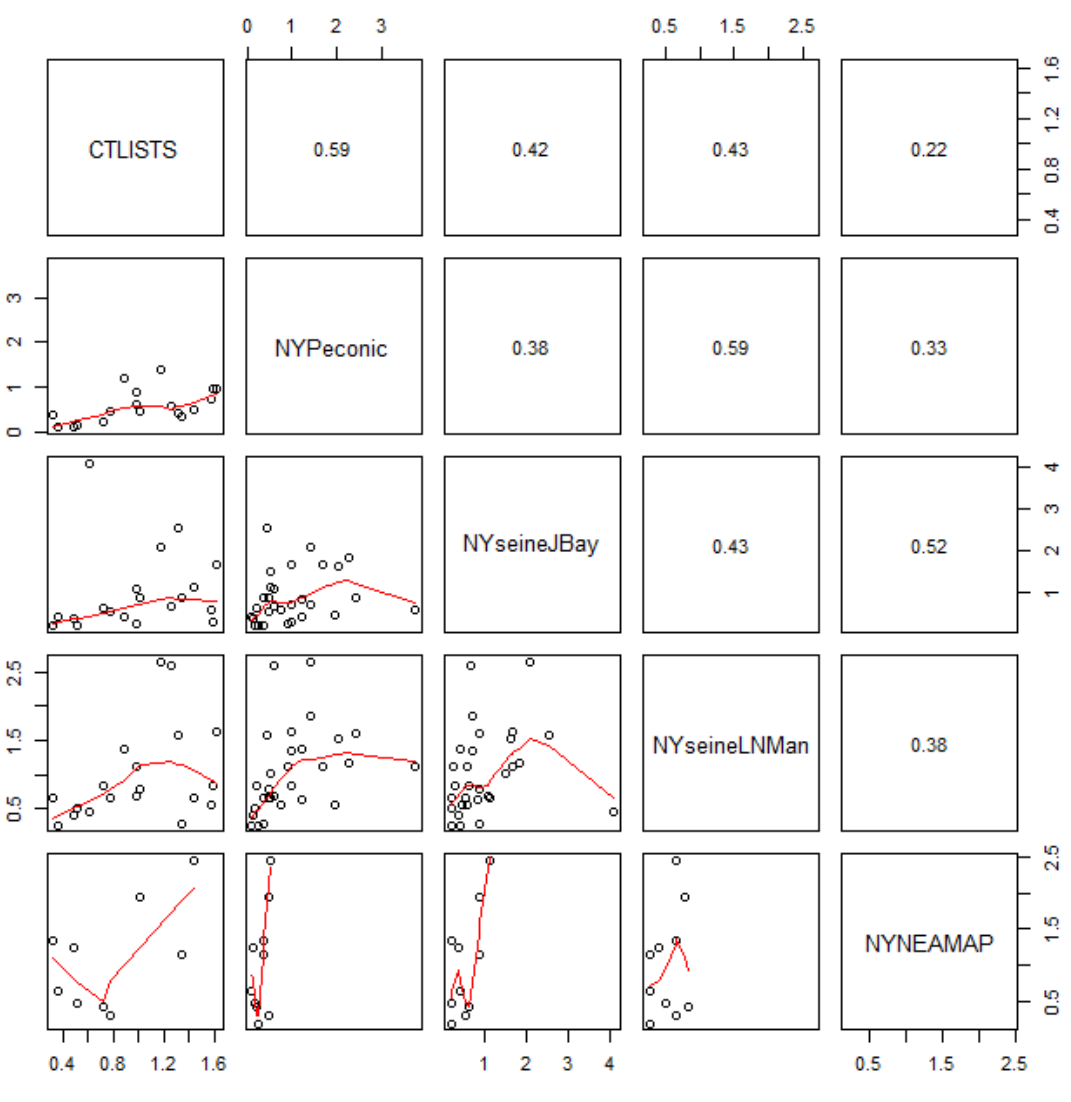
Figure 74. Correlation coefficients and scatter plots for the horseshoe crab abundance indices in the New York Region for 1987-2016. All correlations are insignificant ( P >0.05) except for the positive correlation between the Connecticut Long Island Sound Trawl Survey and New York’s Peconic Bays ( P =0.020) and New York’s NEAMAP portion and the New York Seine Jamaica Bay ( P